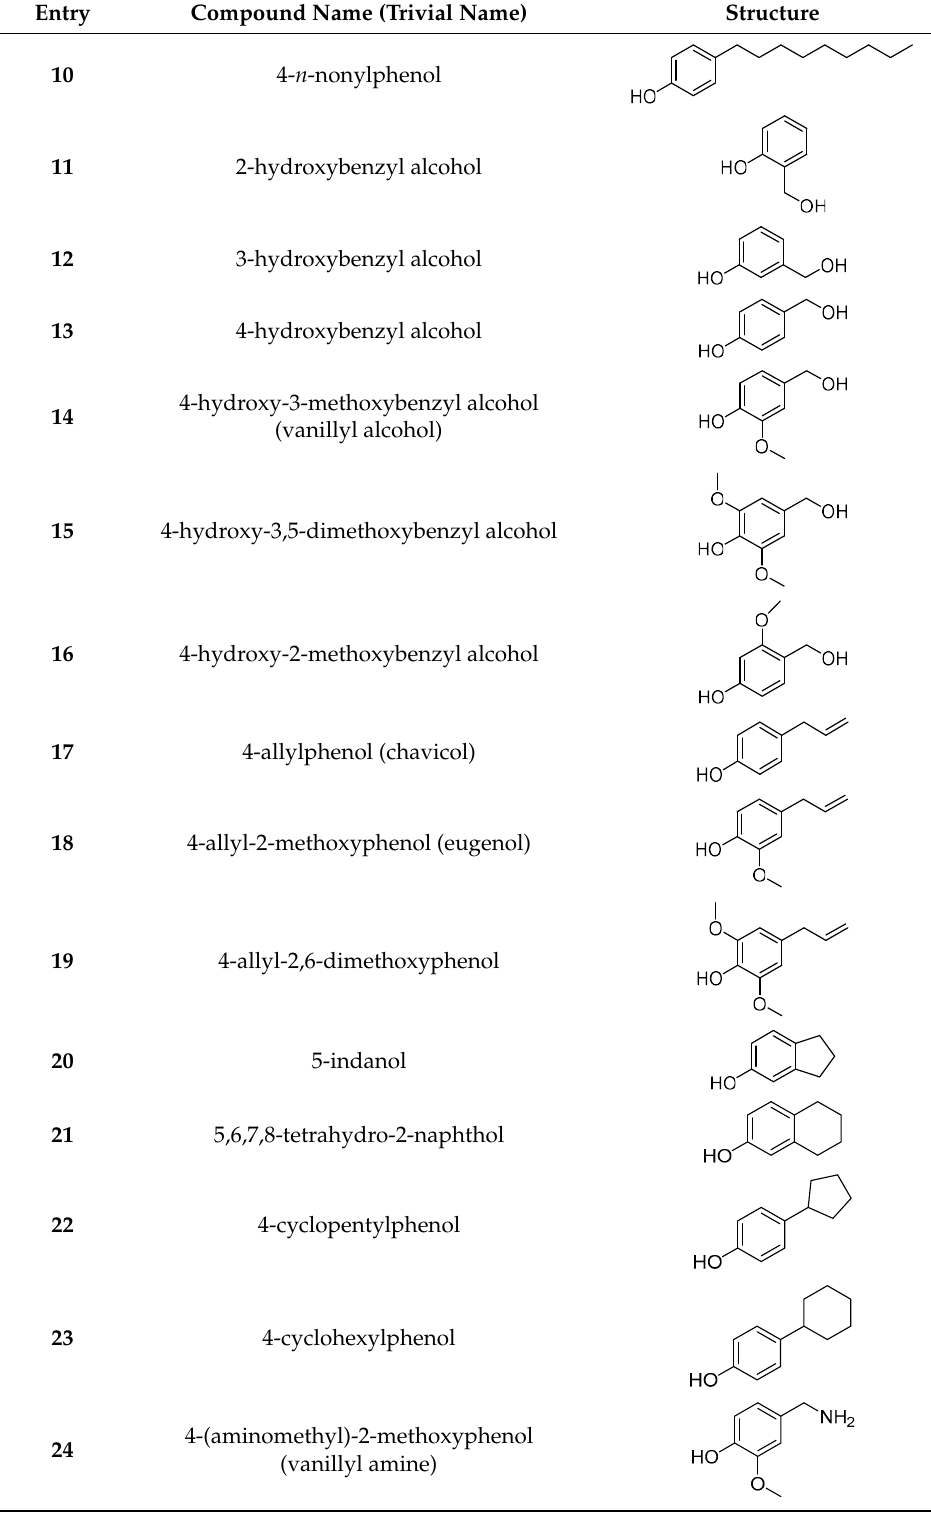
Table 3. Compounds tested in the substrate specificity screening.